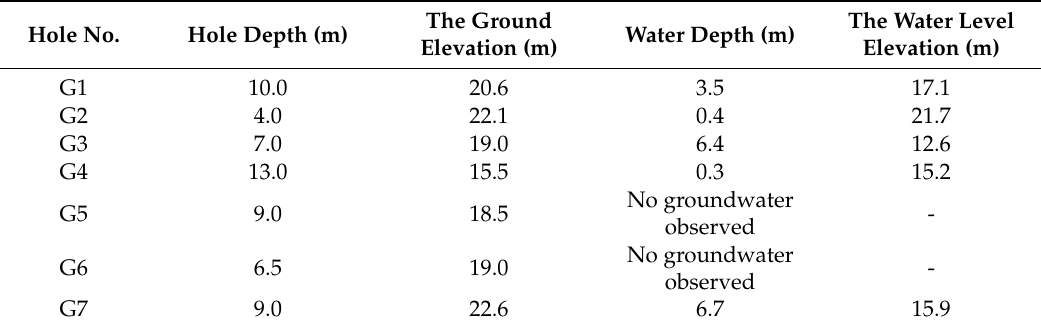
Table 1. Summary of measured water level. Unit: